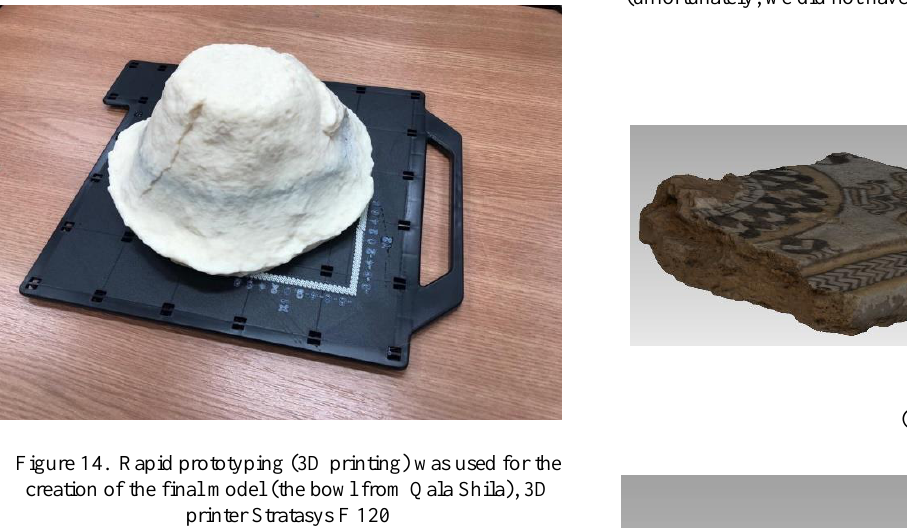
Figure 15. (a,b) Printed copy of the bowl; the missing part is completed on the basis of the assumed rotational shape (unfortunately, we did not have time to colour the printed copy)